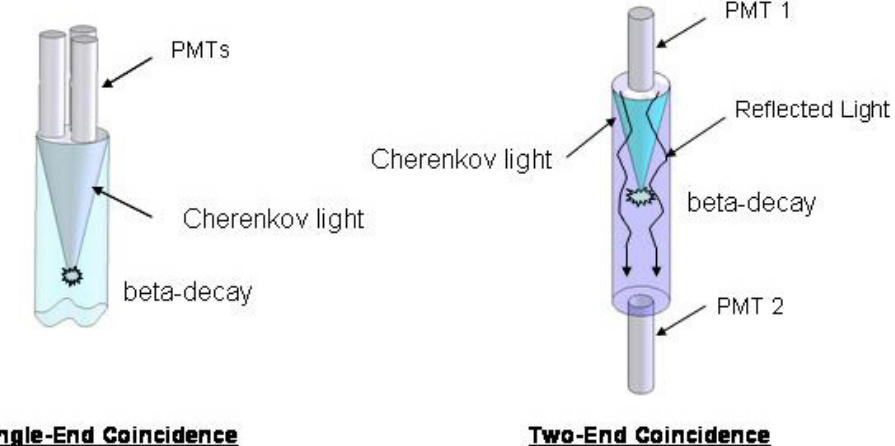
Figure 4. Two possible coincidence techniques that serve to reject PMT dark current events.